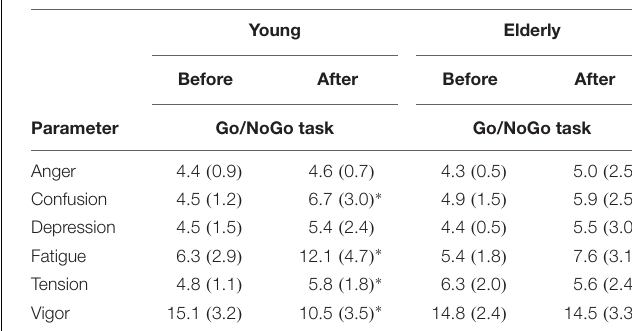
TABLE 1 | Mood state before and after a 2 h “Go/NoGo”